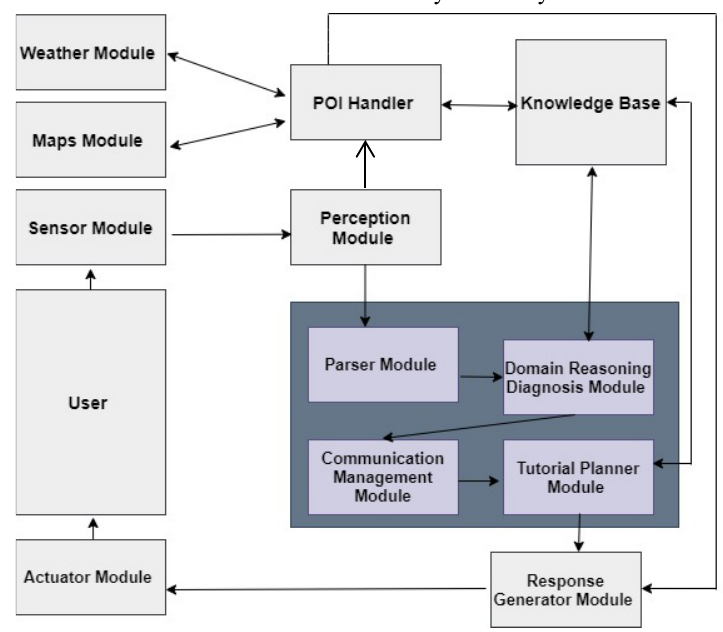
Fig. 1. The proposed model for the tourist facilitator and information